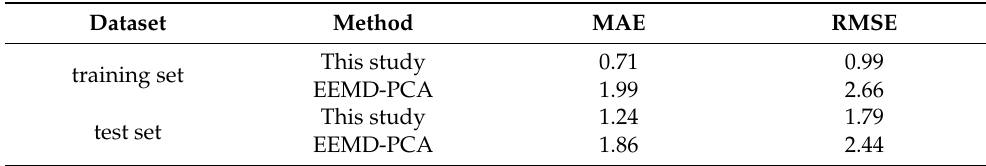
Figure 5. The EEMD-PCA method and respiration rate prediction model proposed in this study with different subjects and time windows for the estimation of mutant respiration rates were assessed for consistency with impedance respiration rates. (The red dotted line represents the referenced impedance respiration rate (RR I ), the blue dotted line denotes the respiration rate predicted by the respiration rate prediction model proposed in this study (RR M ), and the green dotted line indicates the respiration rate estimated by the EEMD-PCA method (RR P )). Table 3. Mean absolute error (MAE) and root mean square error (RMSE) for the RR M (RR estimated by the prediction model proposed in this study) and RR P (RR estimated by the EEMD-PCA method) with the RR I in the training set and testing